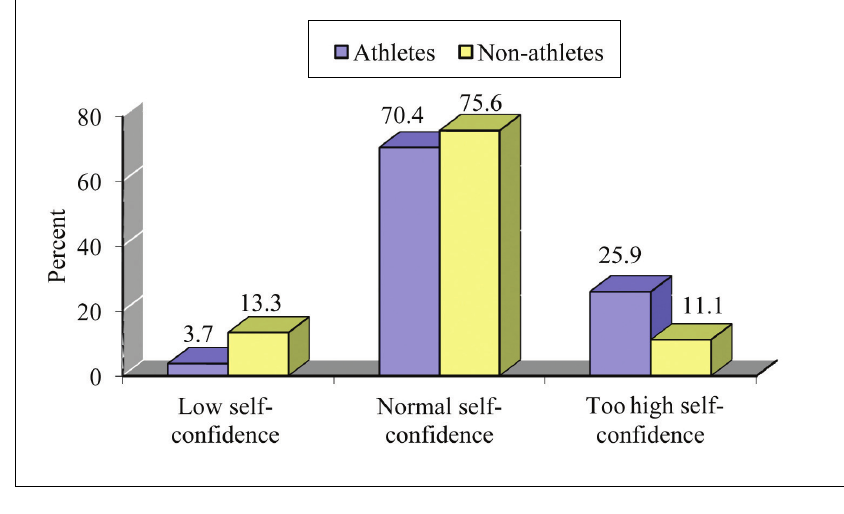
Figure 2. Self-confidence of adoles - cent athletes and